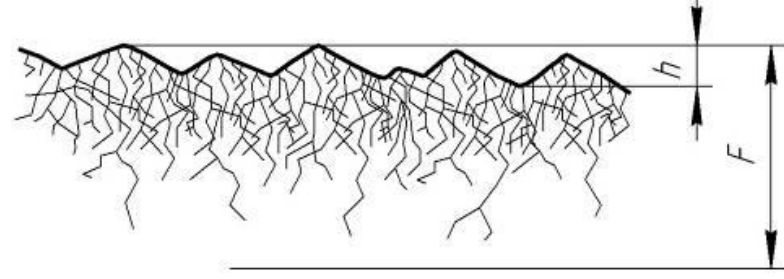
Figure 1. Structure of the deformed layer during lapping of brittle materials.